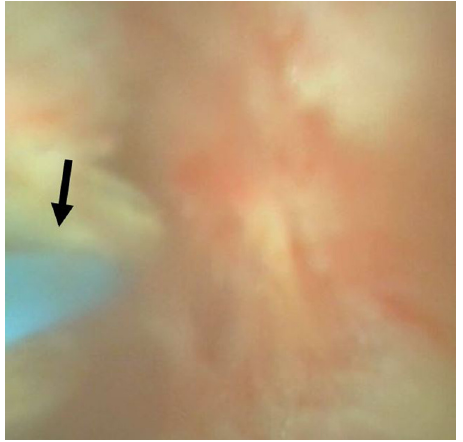
Figure 5: The retrieved specimen from RIRS ( 12 cm ) .